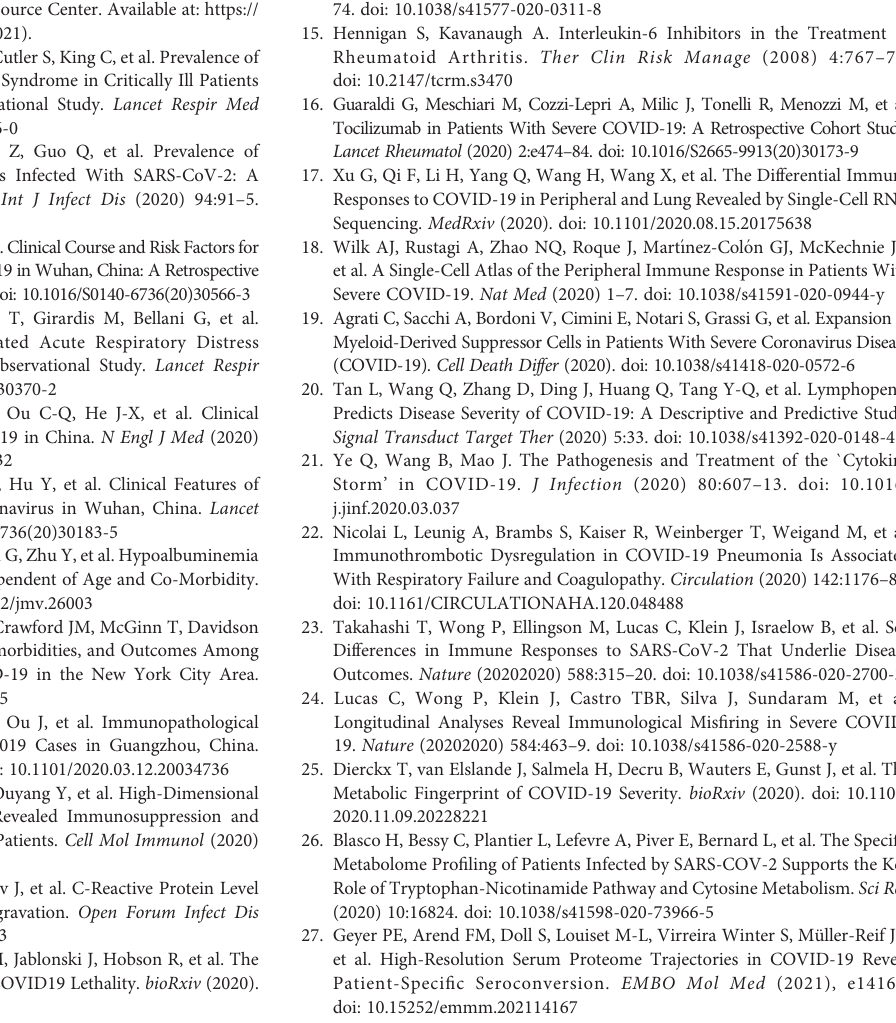
Supplementary Figure 4 | Metabolic changes associated with tocilizumab treatment in COVID-19. (A) Association of metabolite abundance with the time of tocilizumab treatment for all metabolic species (upper panel). The lower panel illustrates the 10 metabolites most associated in each direction. (B) Heatmap of metabolites signi fi cantly associated with tocilizumab treatment for samples of patients that have been treated. Volcano plot of clinical variables associated with COVID-19severityinourcohort. (C) Enrichmentofmetaboliteclassesinthechange with tocilizumab treatment. (D – F) Abundance of metabolites with discordant (D) , concordant (E) or indifferent (D) change between COVID-19 severity and tocilizumab treatment for treated patients. Supplementary Figure 5 | Metabolic and clinical association of disease severity. (A) Latent space as in Figure 2A , but illustrating the distribution of additional clinical factors. (B) Association analysis of clinical variables with the latent space axes. p - values have been adjusted with the Benjamini-Hochberg FDR method. (C) Difference between bivariate kernel density estimates that have been weighted with the clinical parameters of the samples. Theoverall risk is the mean ofthe four clinical parametersinthe fi rstrowofplots. (D – F) Latentspaceembeddingsofmetabolomic data using alternative methods. Samples have been colored by the WHO score